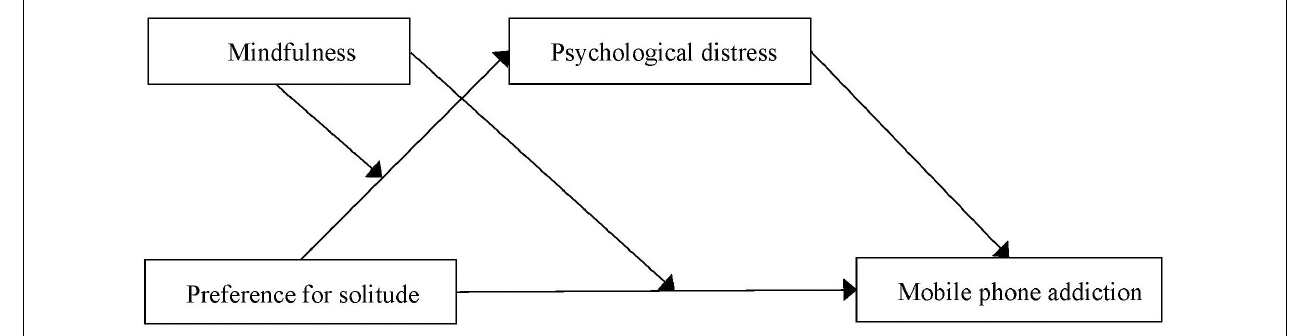
FIGURE 1 | The proposed moderated mediation